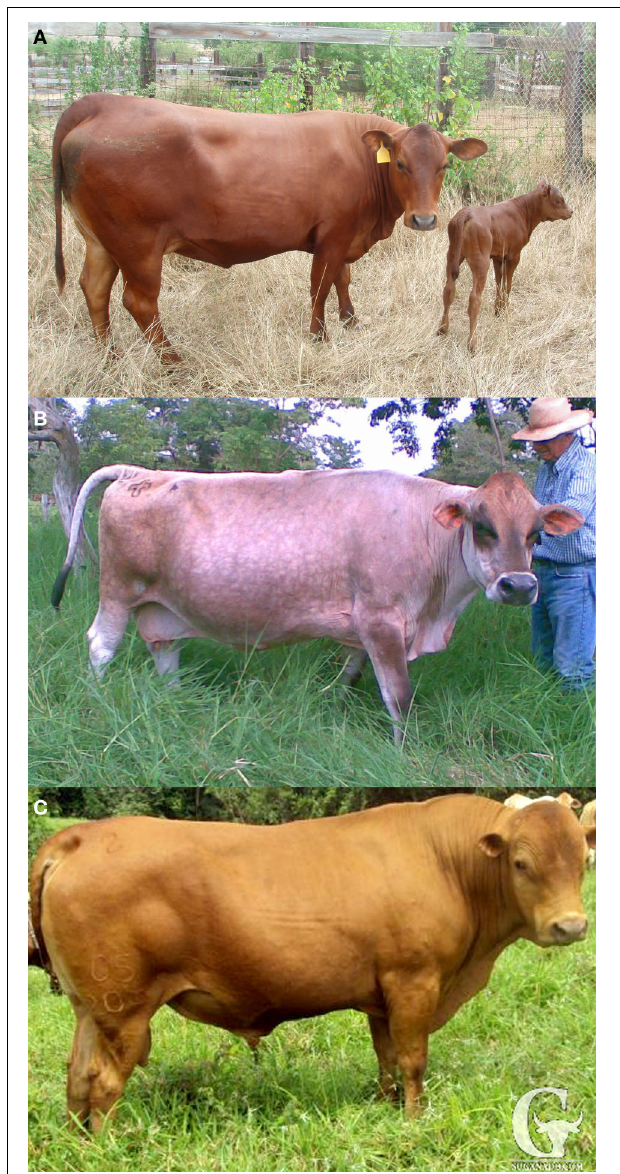
FIGURE 1 | Tropical slick-haired cattle breeds. Three Criollo composite cattle breeds (A) Senepol, (B) Carora, and (C) Romosinuano, exhibit the slick hair coat which has been associated with thermo-tolerance in tropical and sub-tropical climates. The slick phenotype is characterized as a fine, sleek hair coat with fewer hair follicles, shorter hair length, and larger sweat